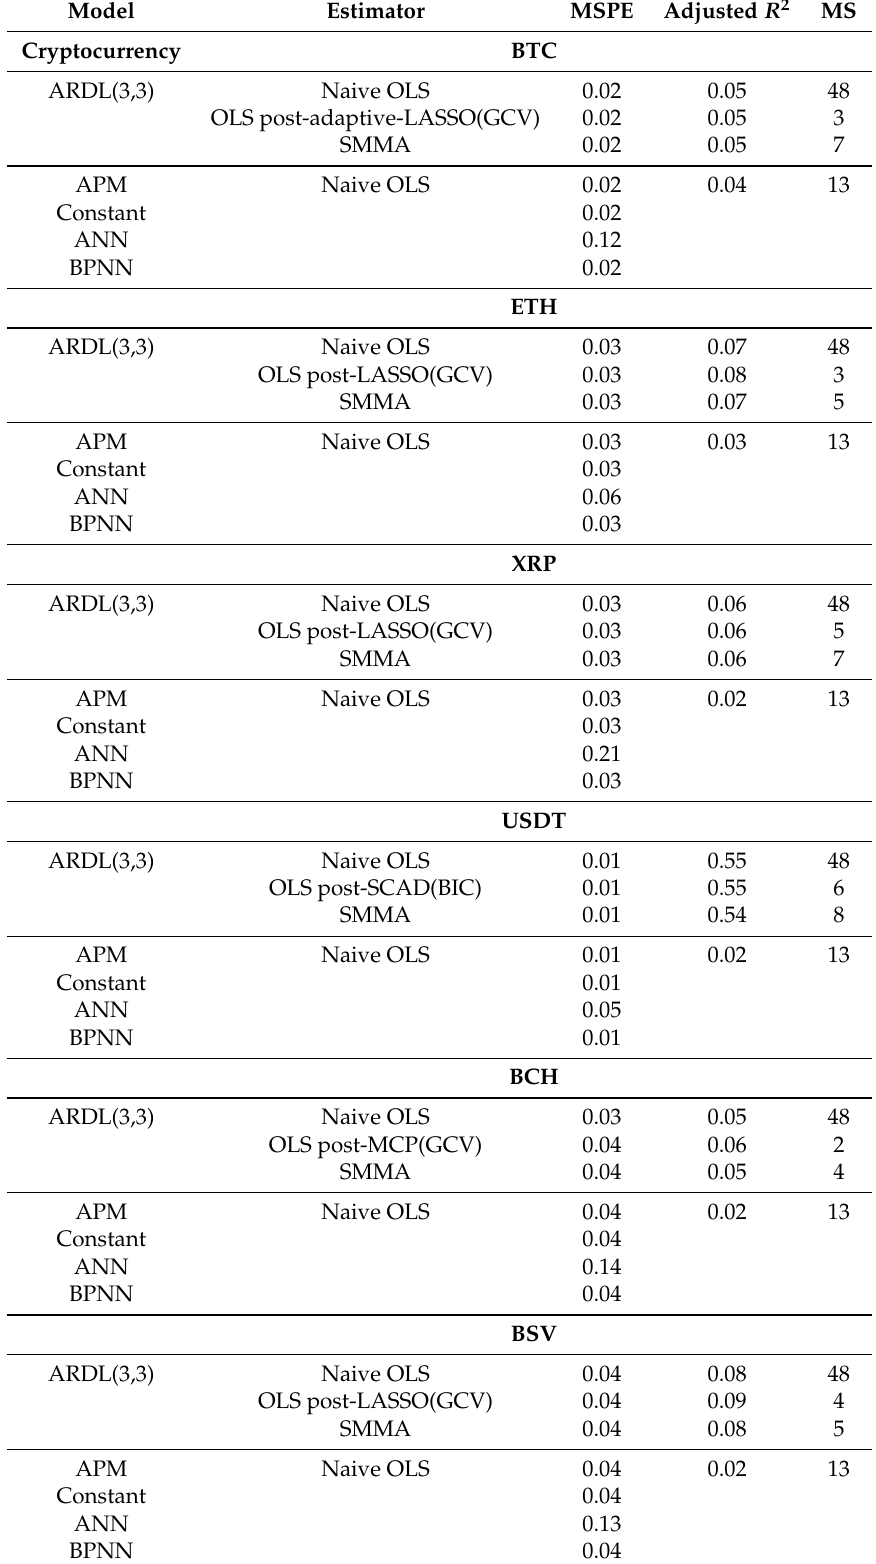
Table 5. Cryptocurrency model and estimator performance evaluation. MSPE, mean squared prediction error; MS, model size; SMMA, shrinkage Mallows model averaging; APM, asset pricing